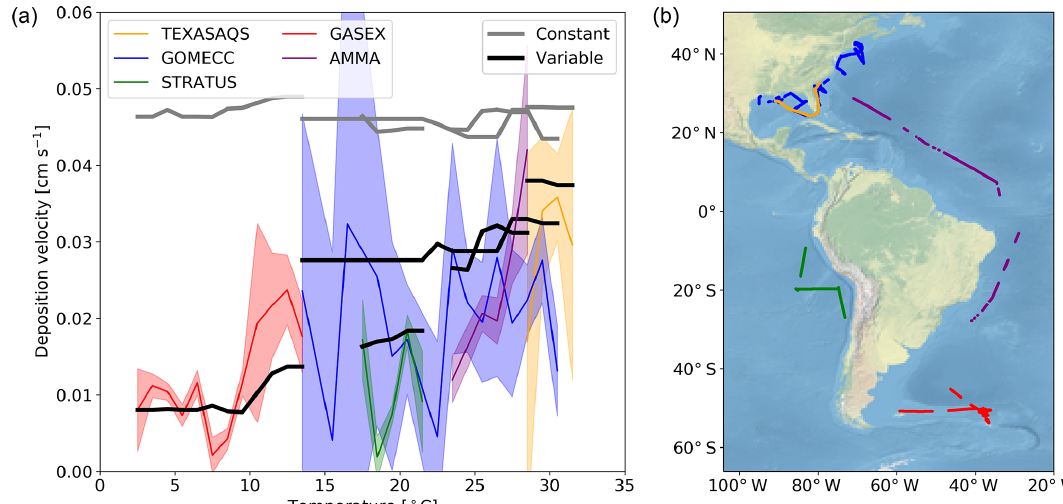
Figure 4. (a) The deposition velocities predicted by the model using the default (constant) value for r c and the new (variable) parameterization of r c compared against the five open-ocean cruise datasets of ozone deposition by Helmig et al. (2012). The solid lines represent the median of the deposition velocity for a 1 ◦ temperature window, with the shaded region representing the 25th to 75th percentiles. (b) The locations along the cruise tracks where the ozone deposition has been